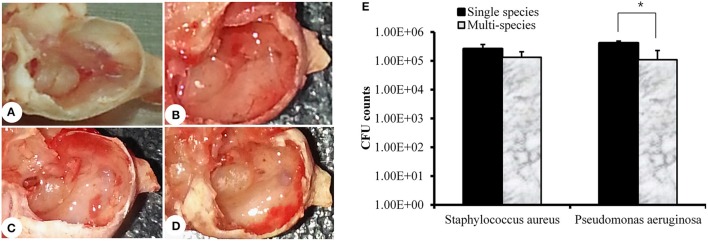
Quantification of methicillin-resistant Staphylococcus aureus (MRSA) and Pseudomonas aeruginosa (PA) in the rat middle ear. (A) Digital image of rat bulla inoculated with media only. (B) Digital image of rat bulla inoculated with MRSA only. (C) Digital images of rat bulla inoculated with PA only. (D) Digital image of rat bulla inoculated with multi-species (MRSA + PA). (E) Colony forming unit (CFU) counts for rat bullae inoculated with single or multi-species MRSA or PA in the rat middle ear.